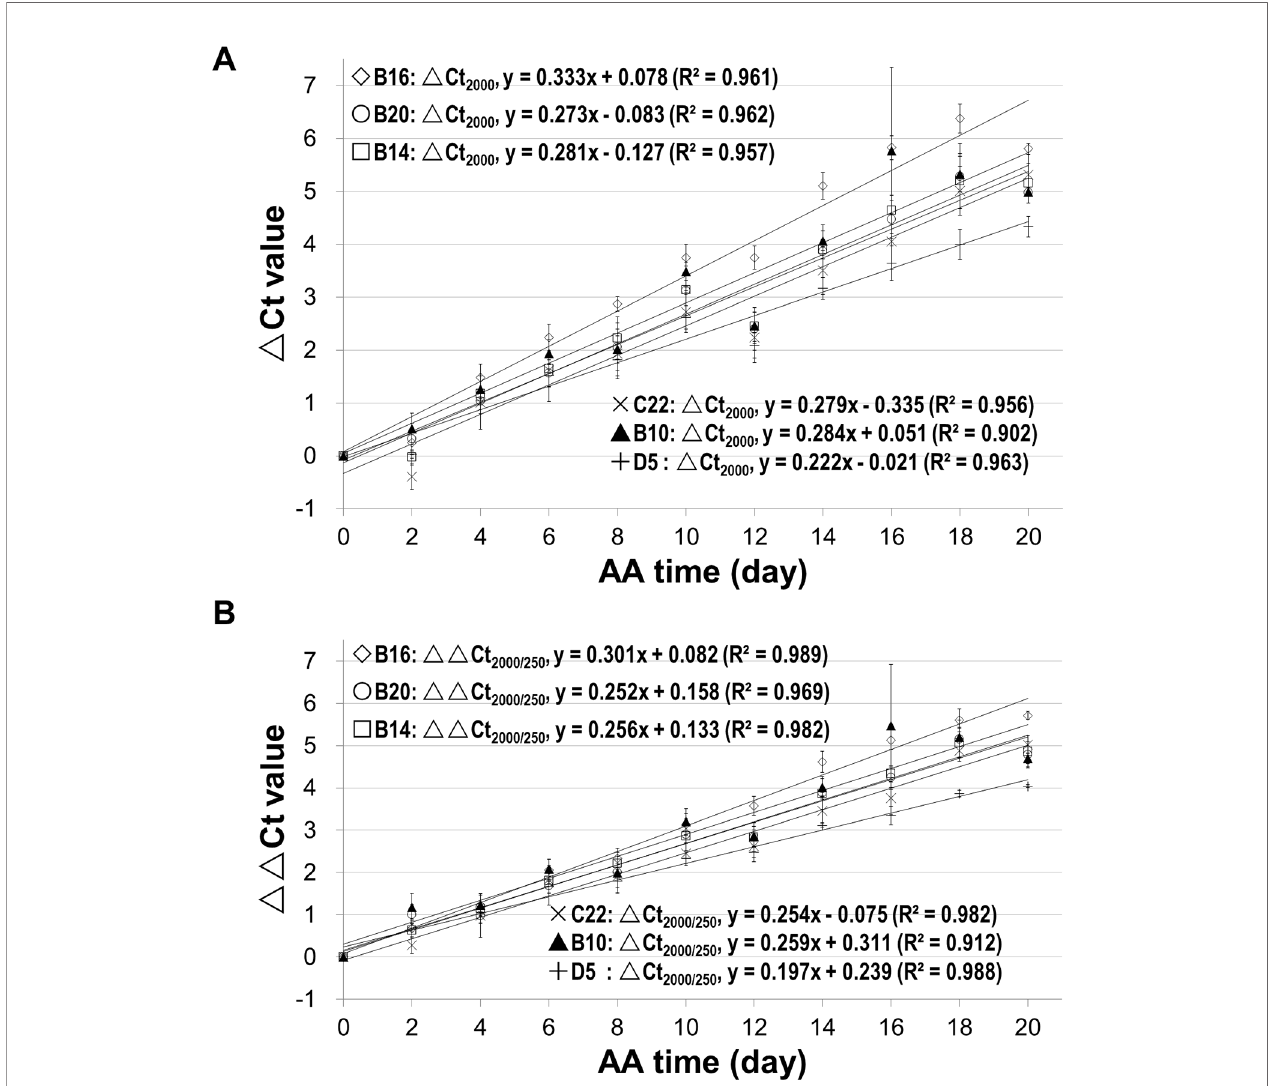
FIGURE 5 | Relationship between the D Ct values from analyzing stored mRNAs of six genes and seed aging time. cDNAs of control and arti fi cially aged (AA) seeds for the indicated time (days) were used. For each of the six genes (B16, B20, B14, C22, B10 and D5), a 2,000bp cDNA fragment was analyzed. D Ct = Ct of the aged sample – Ct of control. All D Ct values are the averages of three biological repeats. (A) Relationship between D Ct value of the 2,000bp fragment ( D Ct2,000) and AA aging time for the six genes. (B) Relationship between normalized D Ct value of the 2,000bp fragment ( DD Ct2,000/250) and AA aging time. DD Ct2,000/250bp